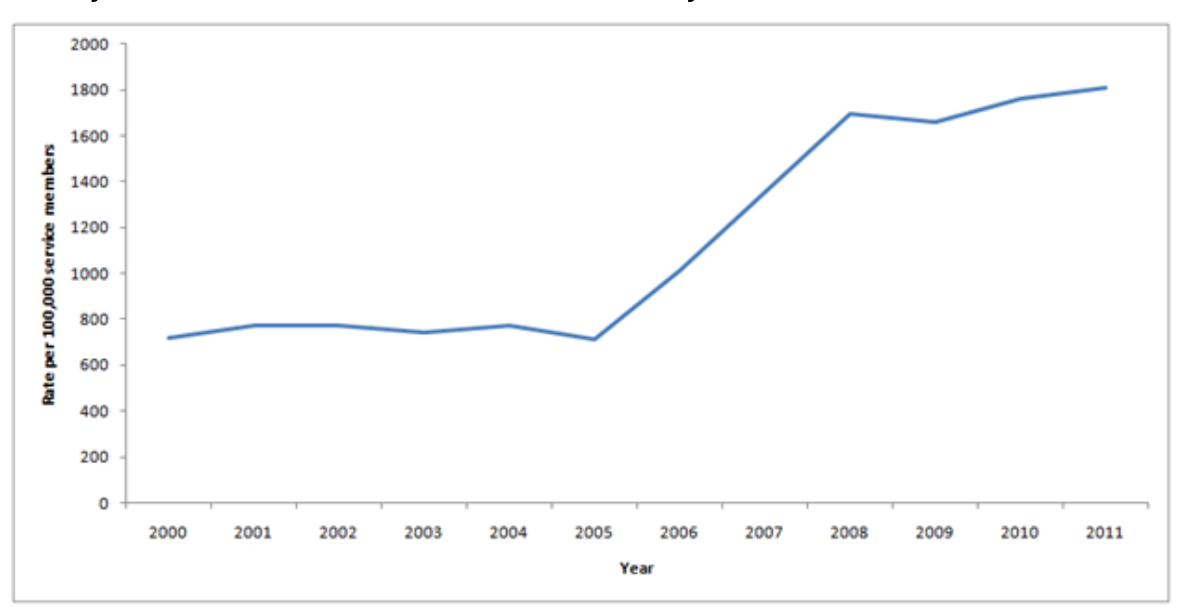
Figure 2. Estimated Overall Annual Incidence Rates of TBI Among Active-Duty U.S.